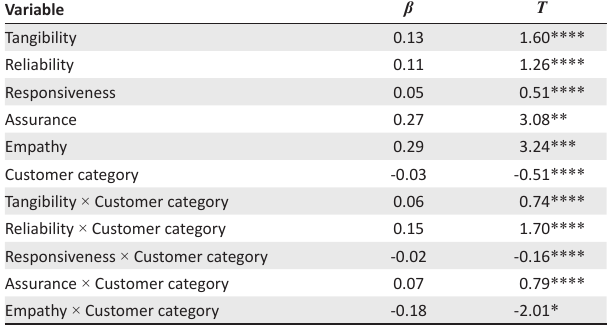
TABLE 6: Moderated multiple regression analysis.